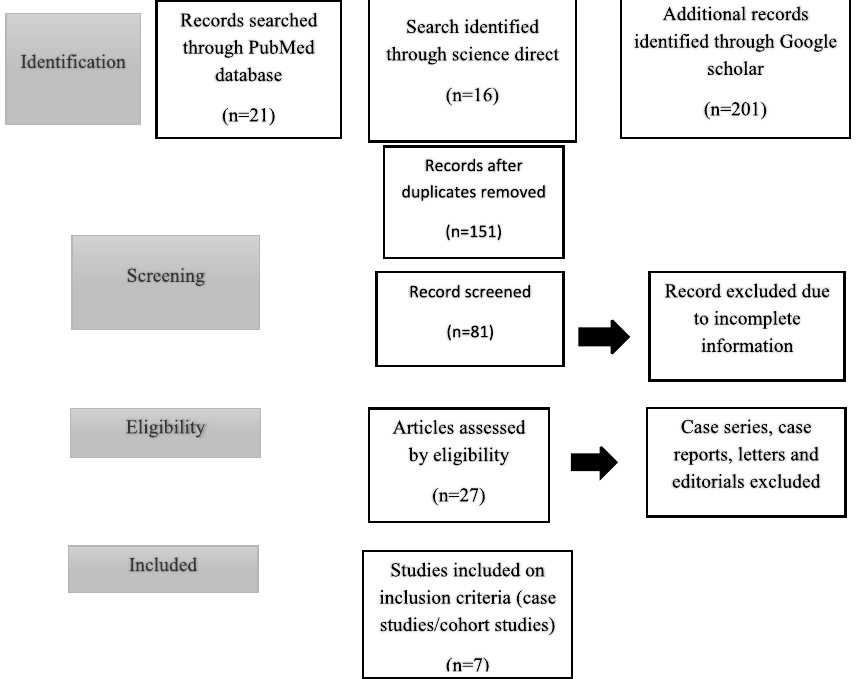
Figure-III : PRISMA 2009 Flow Diagram showing study